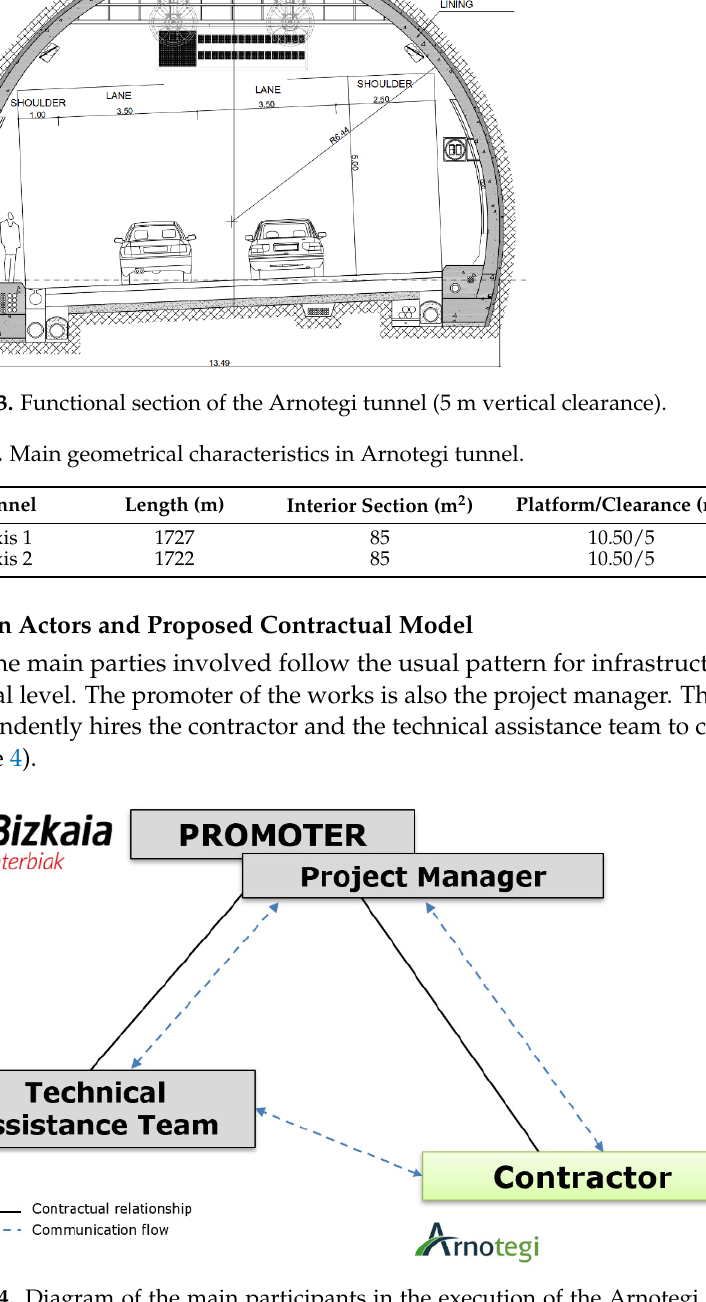
Figure 4. Diagram of the main participants in the execution of the Arnotegi tunnel. Contractual links shown.